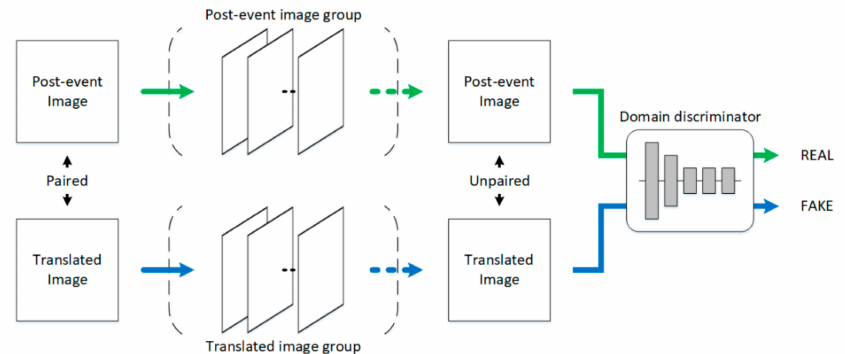
Figure 4. Overview of the group discrimination module. The curved arrows indicate the operations of random